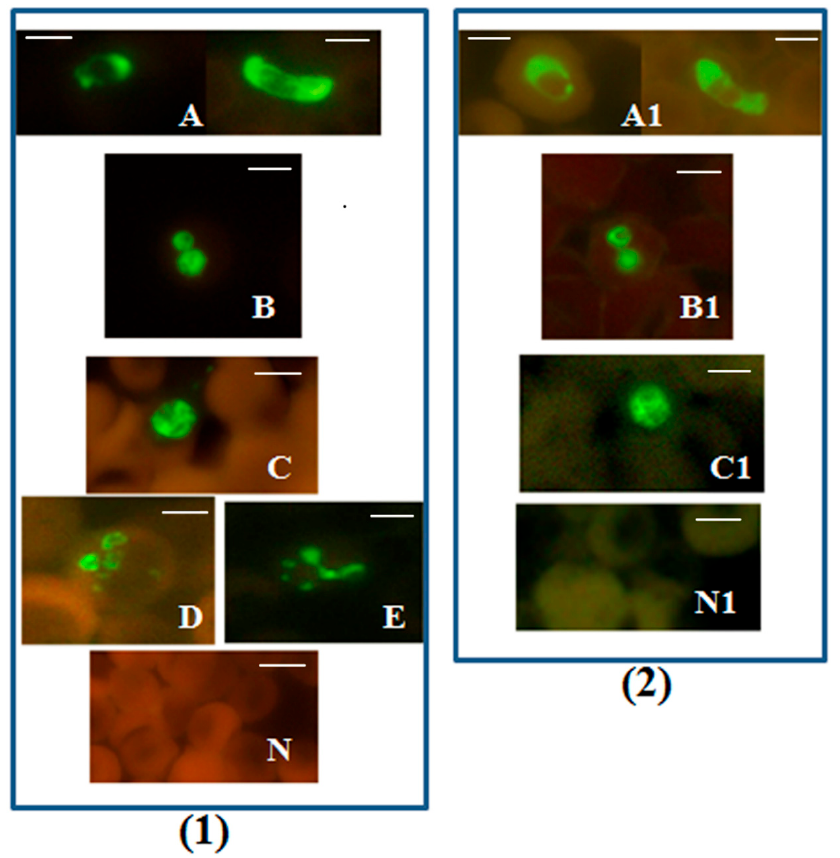
Figure 1. Plasmodium genus-specific FISH test identifying all human malaria parasites. Photographs showing Plasmodium genus-specific FISH test results with blood smears from patients with con- firmed P. falciparum, P. vivax, P. malariae, P. ovale and P. knowlesi infections. Fluorescence was viewed